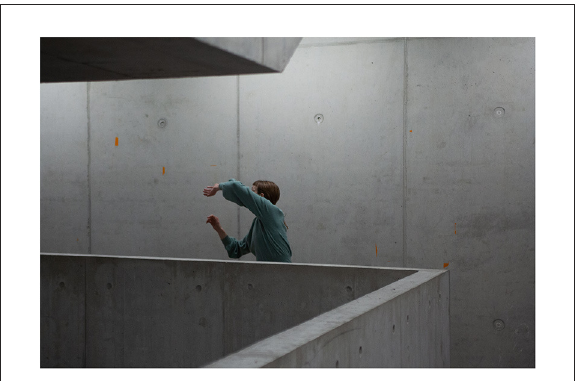
FIGURE7 Sophia Obermeyer tracing lines in architecture as a dance practice. Photo: Niels Weijer.